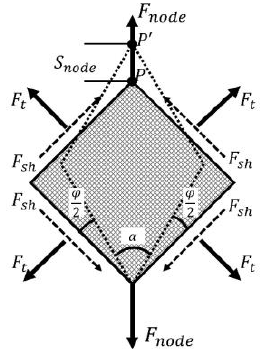
Figure 3. Shear deformation of a fabric RVE.